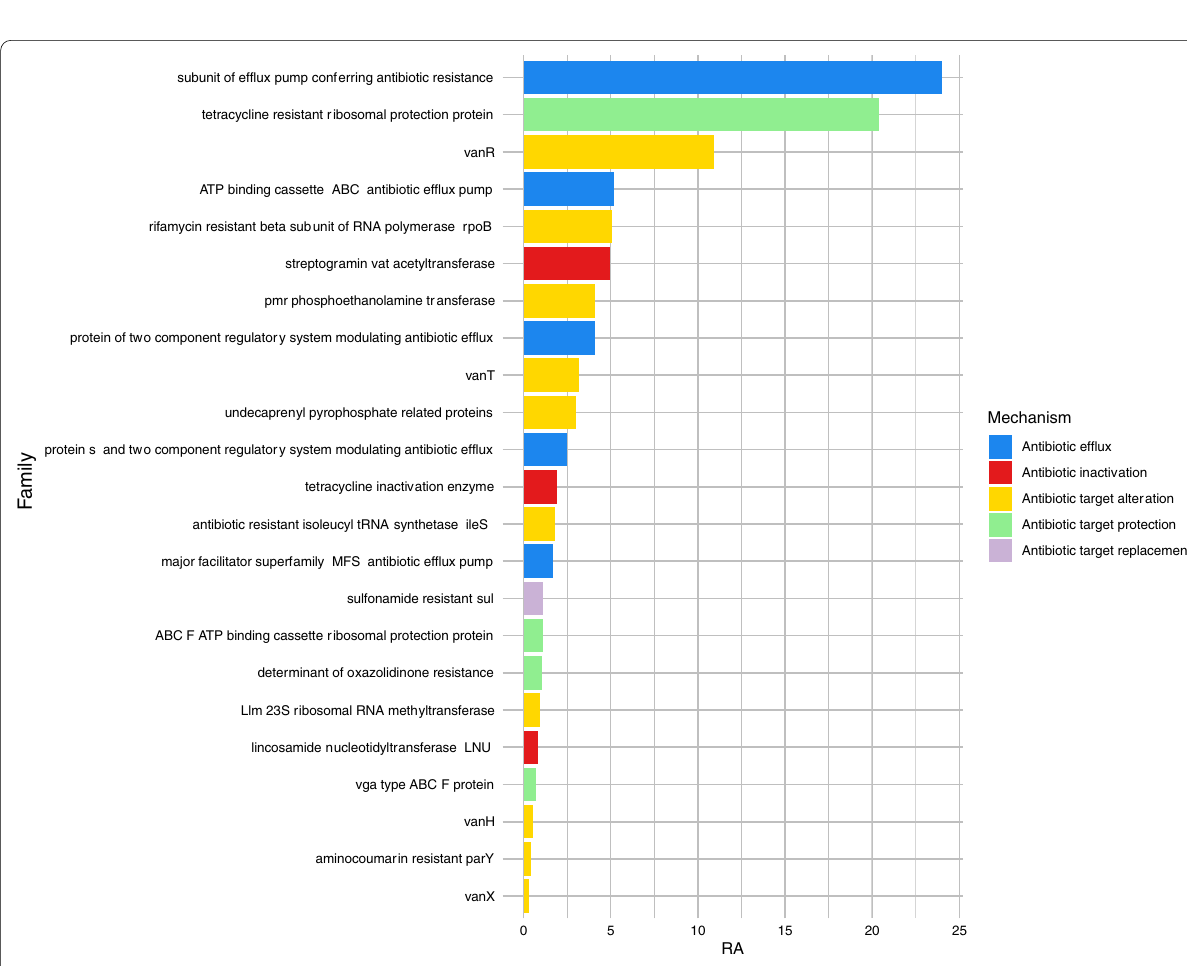
Fig. 2 Relative abundance (%) of the antimicrobial resistance families. The colour represents the resistance mechanisms associated with each family of